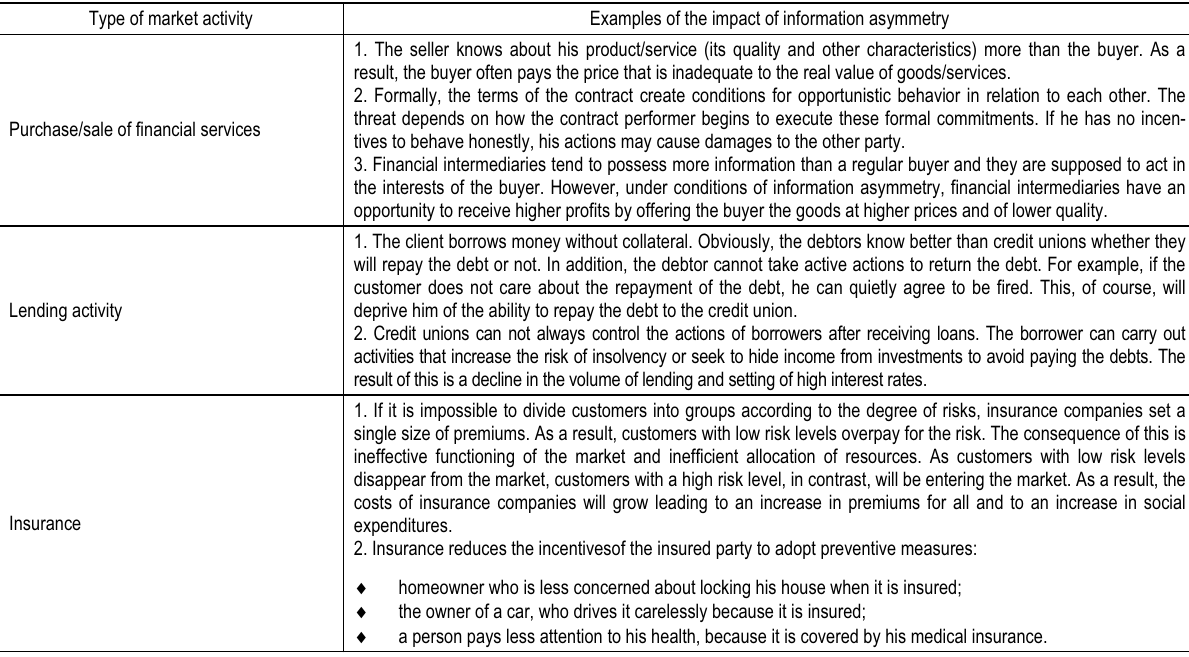
Table A.1. Examples of information asymmetry on the market of non-banking financial services in Ukraine Type of market